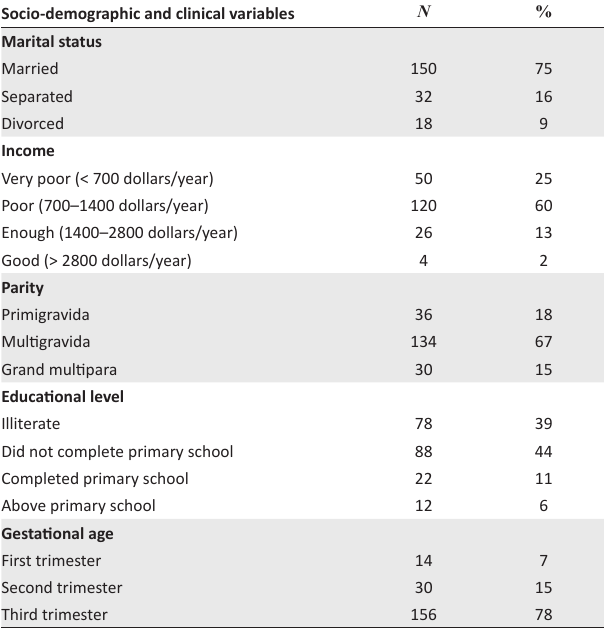
TABLE 1: Distribution of socio-demographic and clinical variables, Sudan, September 2016 to February 2017.